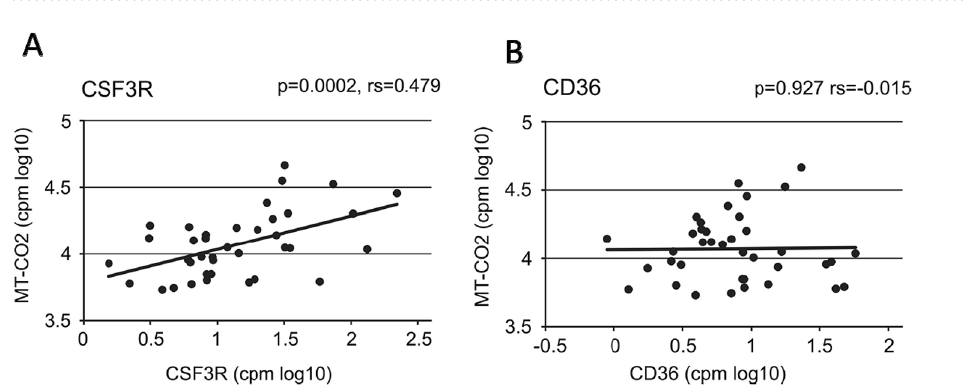
Figure 5. Association of MT-CO2 expression levels with neutrophil and macrophage marker genes. Shown are log transformed expression values in counts per million for MT-CO2 and CSF3R ( A ) and MT-CO2 and CD36 ( B ) in male Aex and Eex samples. p -values were determined using the Spearman’s rank correlation test. Analysis of A and E samples gave the same pattern with a significant correlation for CSF3R but not for CD36, p < 0.0003 and p = 0.062, respectively.